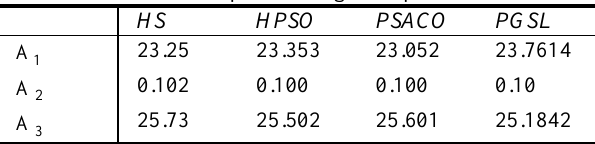
Table 3. 10-bar truss: optimal design comparison for case 2